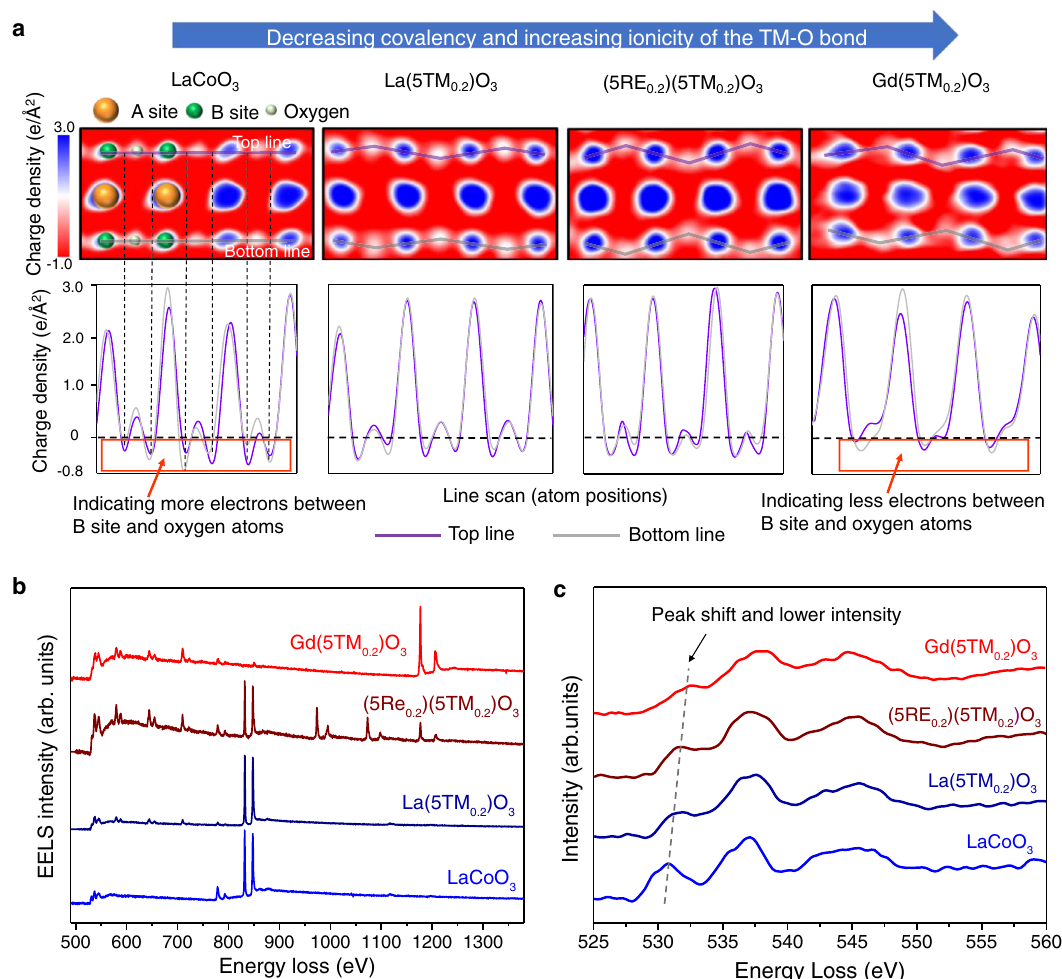
Fig. 5 Real-space charge mapping and EELS analysis of LaCoO 3 and the three P-HEOs. a Charge mapping of the three P-HEOs, indicating a decrease of the covalency and increase of the ionicity of TM – O bond. The colored lines in the line pro fi les of the charge distribution show the variation along the lines (Top line and Bottom line) as indicated in the charge maps. b EELS of LaCoO 3 and the three P-HEOs. c Detailed EELS of O K -edge electron energy-loss near-edges structures of the four samples. The dash line in ( c ) is a guide to eye showing the right shift of the lowest-energy O K